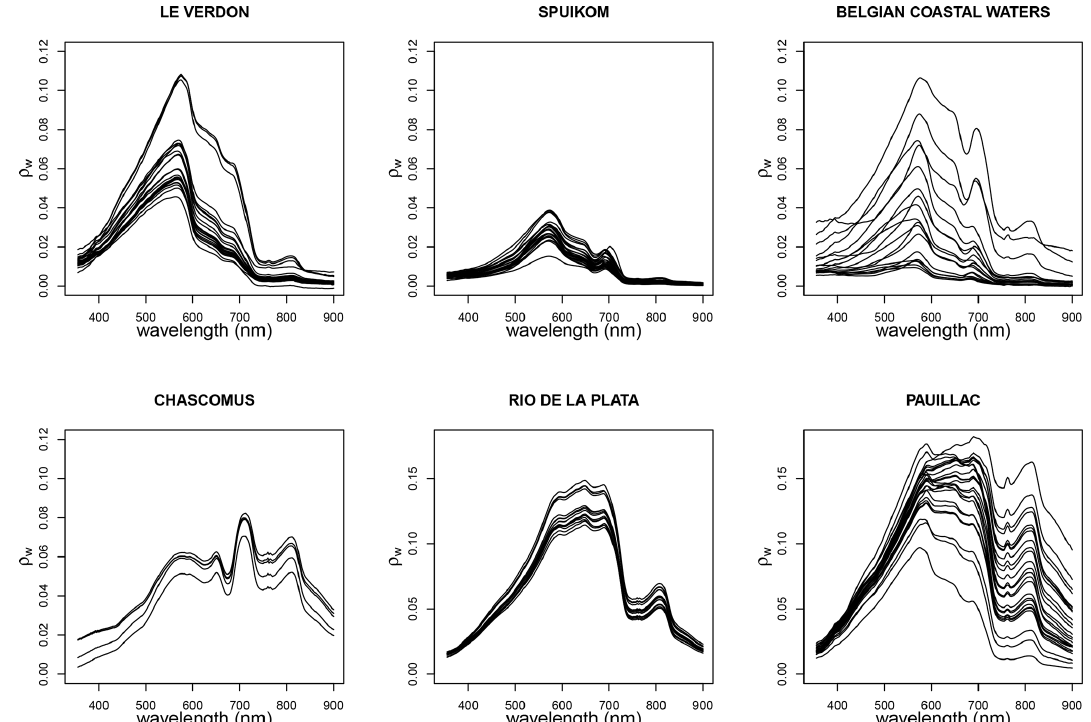
Figure 8. Water reflectance spectra (unitless) from each sample